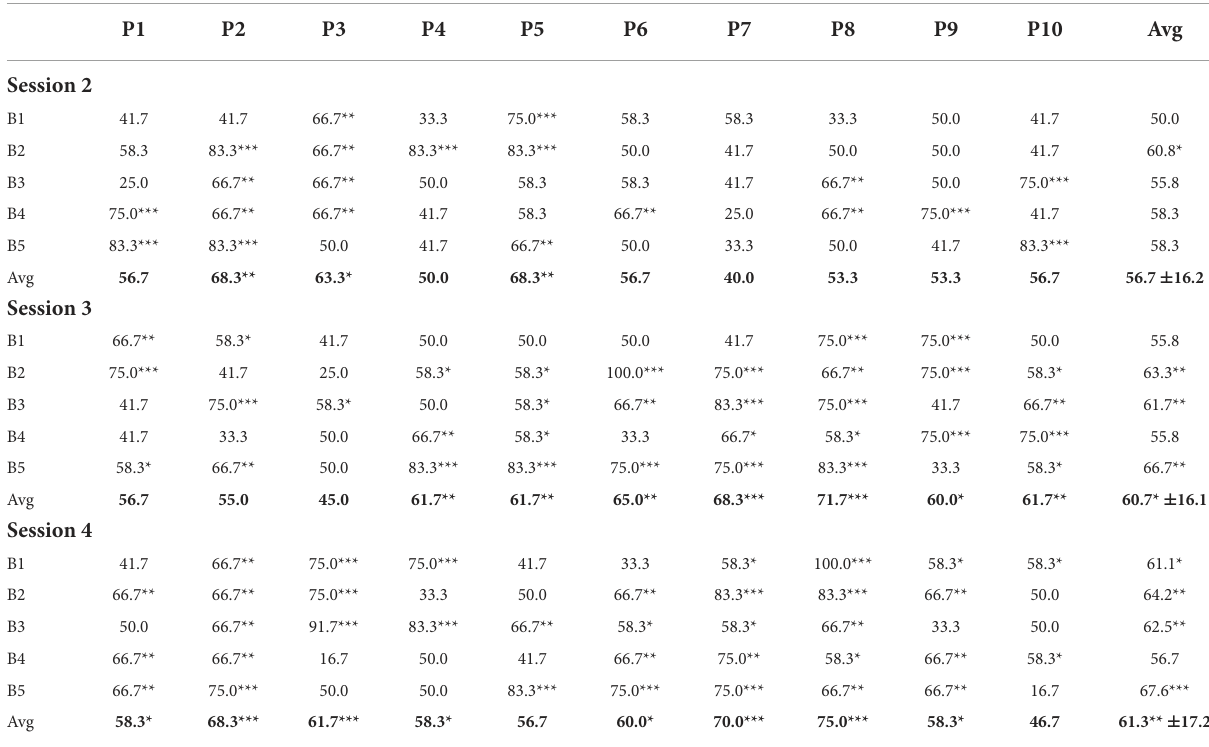
TABLE 1 Online classification accuracies for each session, broken down by block (B1–B5).